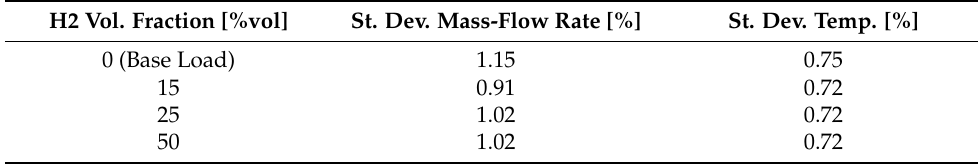
Table 7. Steady-state solution assessment.